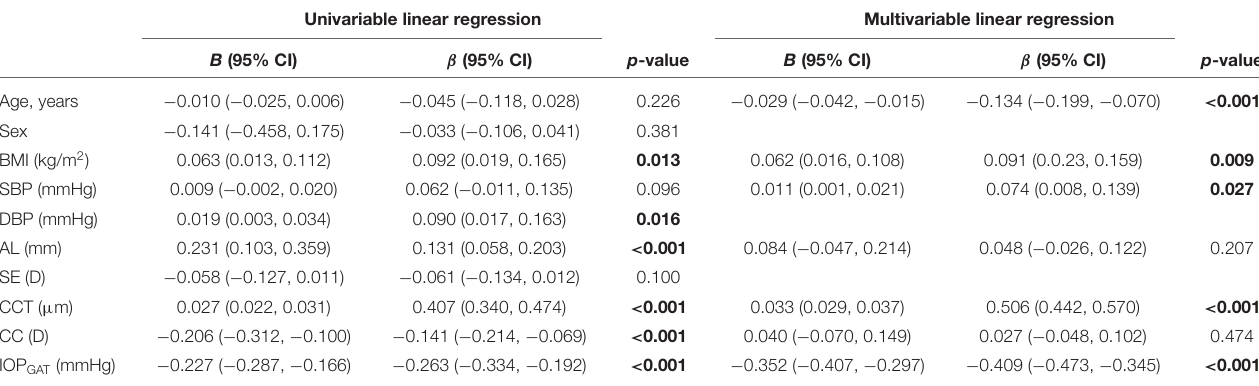
TABLE 4 | Univariate and multivariable linear regression analyses of factor that affect IOP NCT − GAT . Univariable linear regression Multivariable linear regression